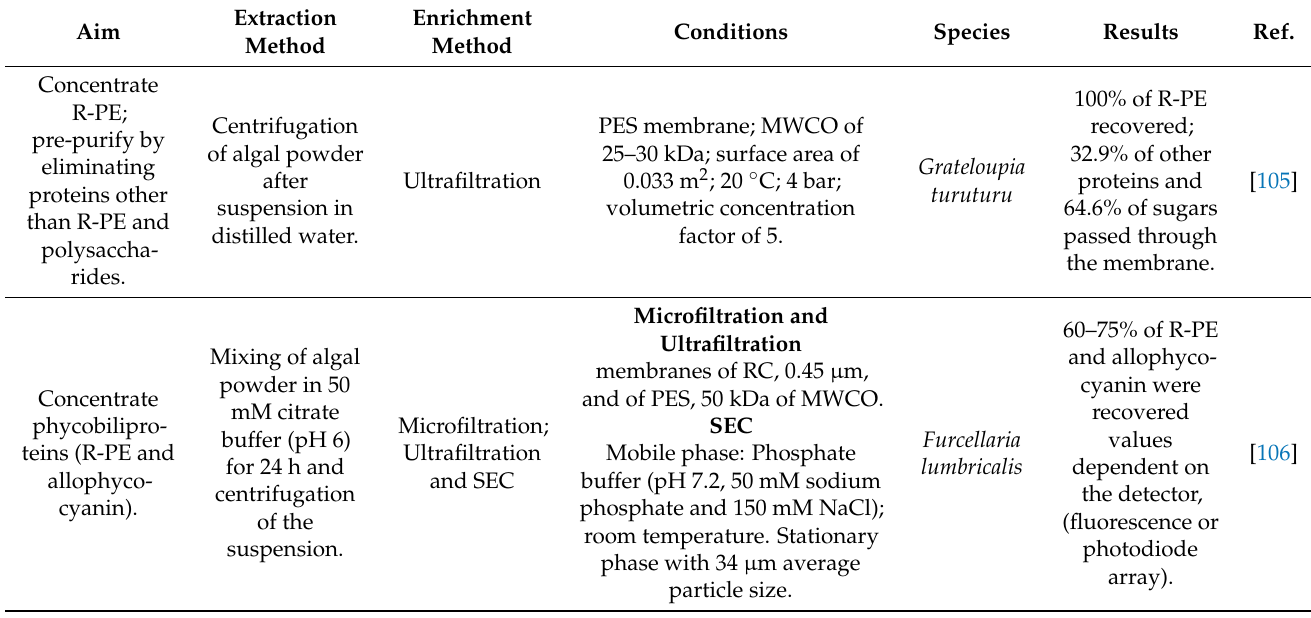
Table 4. Examples of proteins from algae species and the methods tested for their